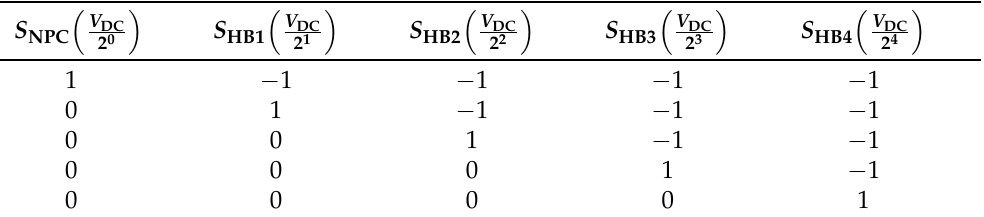
Table 1. Switching-state combinations for v out = V DC ble